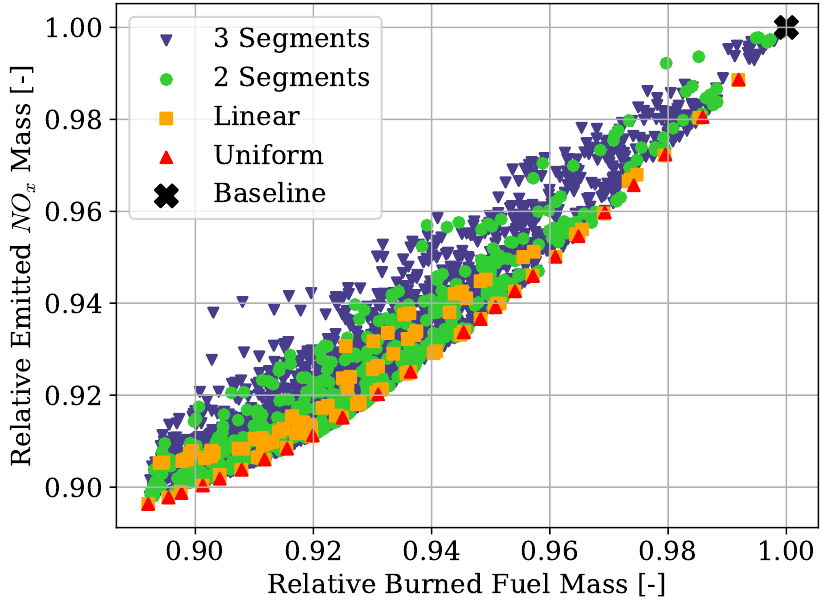
Figure A1. Objective space of cruise-only hybridised strategies.